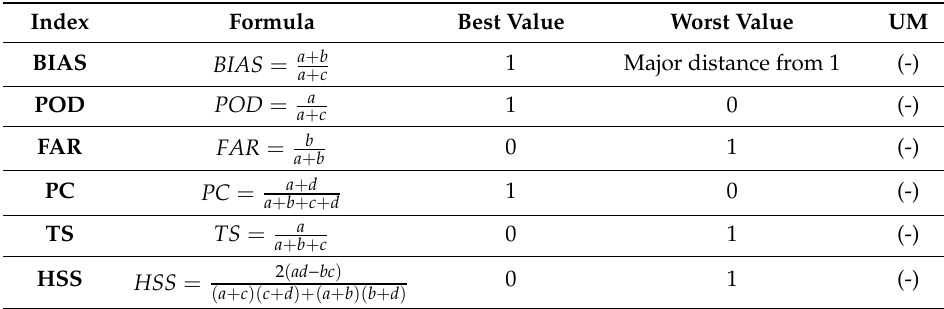
Table 4. Formula, best and worst values and unit of measure (UM) for categorical indices.